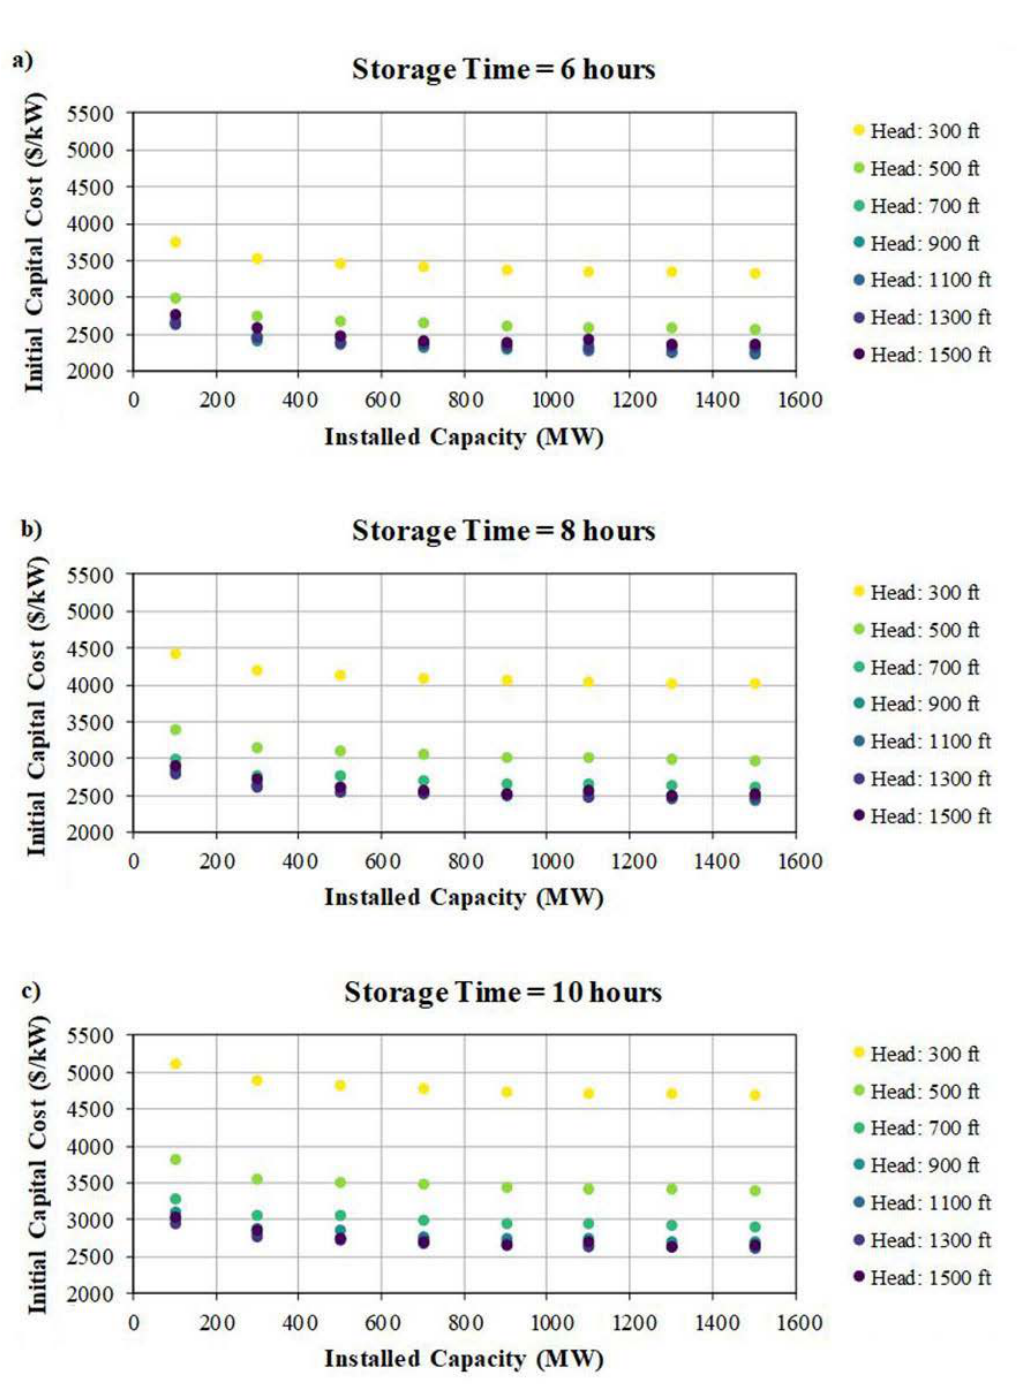
Figure 2. Initial capital cost estimates for greenfield PSH development for ( a ) 6-h, ( b ) 8-h, and ( c ) 10-h storage durations.